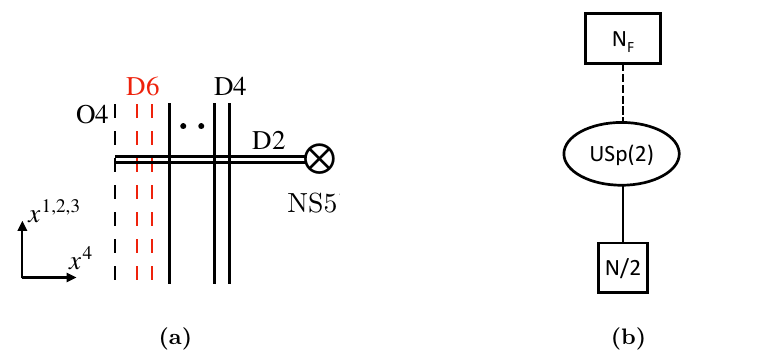
Figure 27. (a): the brane configuration for the monopole screening contribution to the v = 0 sector in h T i . (b): the corresponding quiver ∧ 2 V